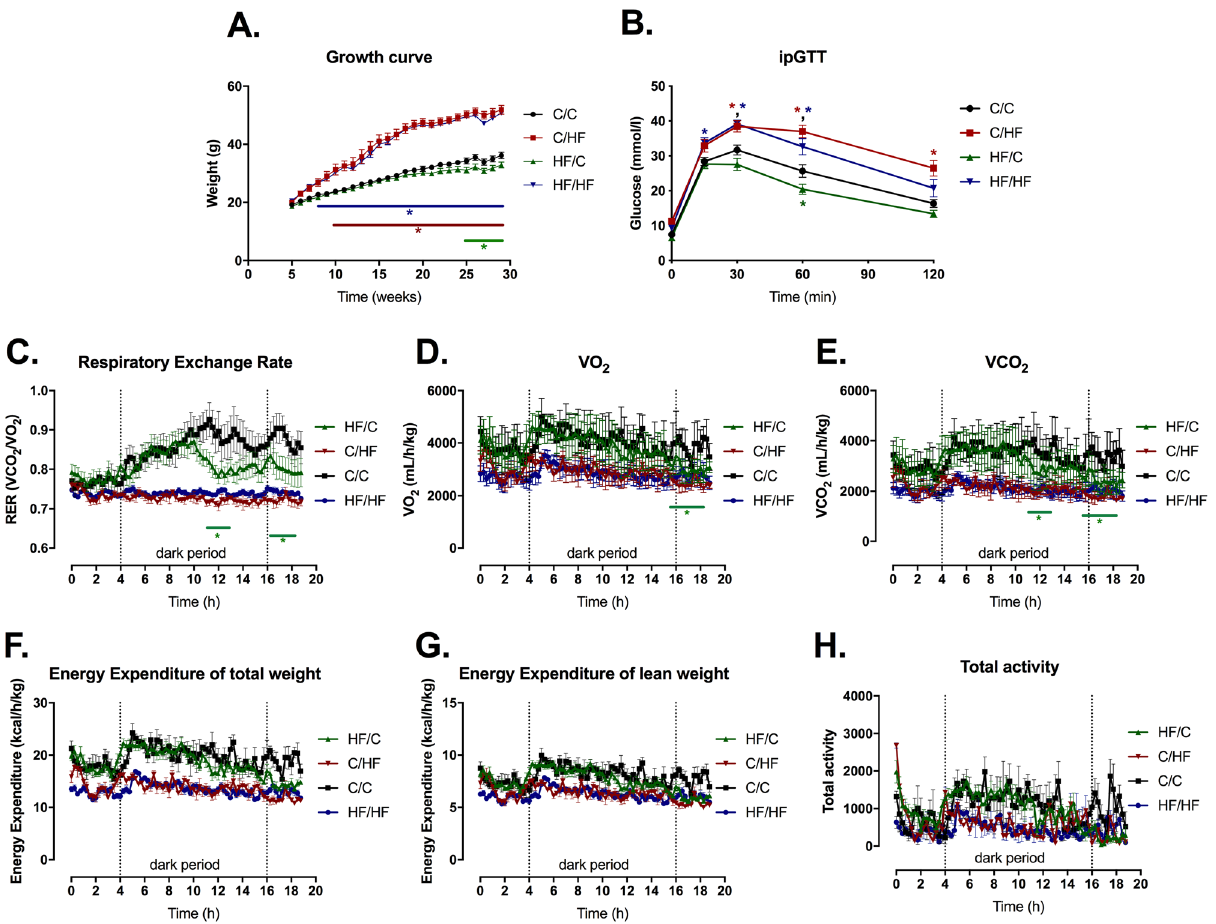
Figure 1. Metabolic effects of maternal obesity depend on male offspring diet. ( A ) Growth curve with weekly weight measures. ( B ) Intraperitoneal glucose tolerance test (ipGTT) with glucose measured at 0, 15, 30, 60 and 120 min after glucose injection. ( C ) Respiratory exchange rate (RER), ( D ) maximum rate of oxygen consumption (VO 2 ), ( E ) maximum rate of carbon dioxide consumption (VCO 2 ), ( F ) energy expenditure of total weight, ( G ) energy expenditure of lean weight and (H) total ambulatory activity were measured in individual mice placed in a metabolic cage for 20 h. C/C, dam and offspring fed standard laboratory diet; C/HF dam fed standard laboratory diet and offspring fed high-fat diet; HF/C dam fed high-fat diet and offspring fed standard laboratory diet; HF/HF dam and offspring fed high-fat diet. For ( A ) and ( B ), n = 10–17 mice from 7–9 litters per group. For ( C – H ), n = 4 animals from 3 litters for C/C, n = 3 animals from 3 litters for C/HF, n = 8 animals from 4 litters for HF/C and n = 8 animals from 4 litters for HF/HF. Data on graphs show mean ± SEM. Data analysed by repeated measures two-way ANOVA with Tukey’s multiple comparisons test. *p < 0.05 and colour of stars indicate significance of the group against